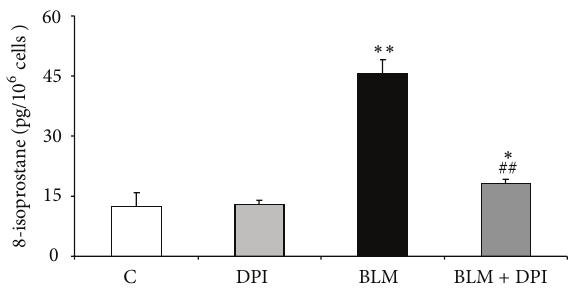
Figure 4: Involvement of NOX activity in BLM-induced 8-epi- PGF 2𝛼 release. Levels of F 2 -isoprostanes (8-epi-PGF 2𝛼 ) were deter- mined in the media of HLF from 3 donors treated with BLM (50 mU/mL) for 24 h, in presence or absence of DPI (1 𝜇 M), a broad NOX activity inhibitor. Data are mean ± SD of 3 separate experiments, each performed in triplicate. ∗ 𝑃 < 0.05 versus control (C); ∗∗ 𝑃 < 0.01 versus control (C); ## 𝑃 < 0.01 versus